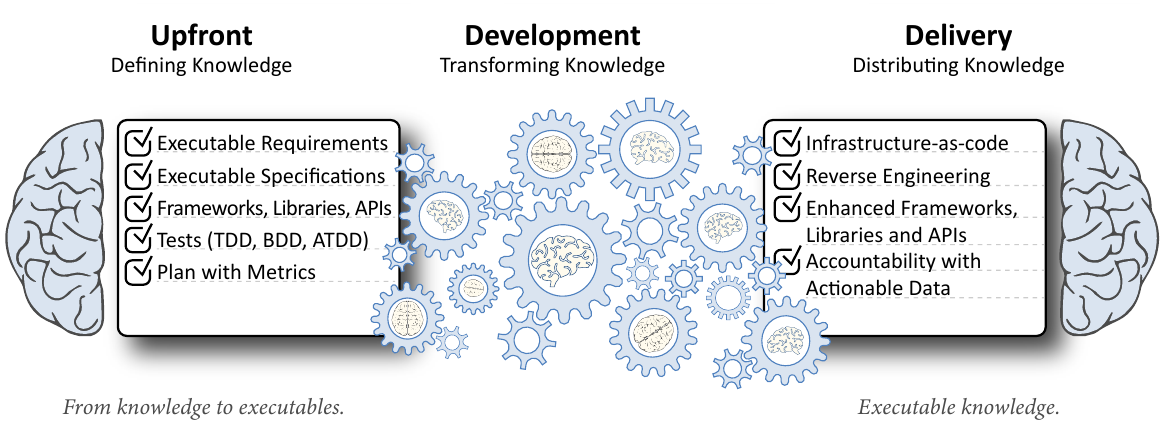
Figure 5. Executable documentation in consecutive